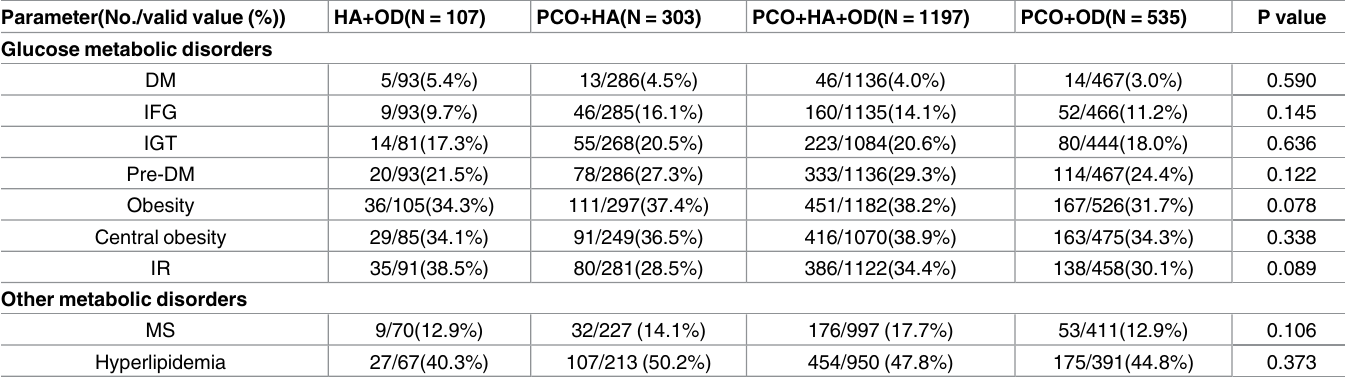
Table 2. Prevalence of Metabolic Disorders Among the PCOS Phenotypes (age (cid:21) 18). Parameter(No./valid value